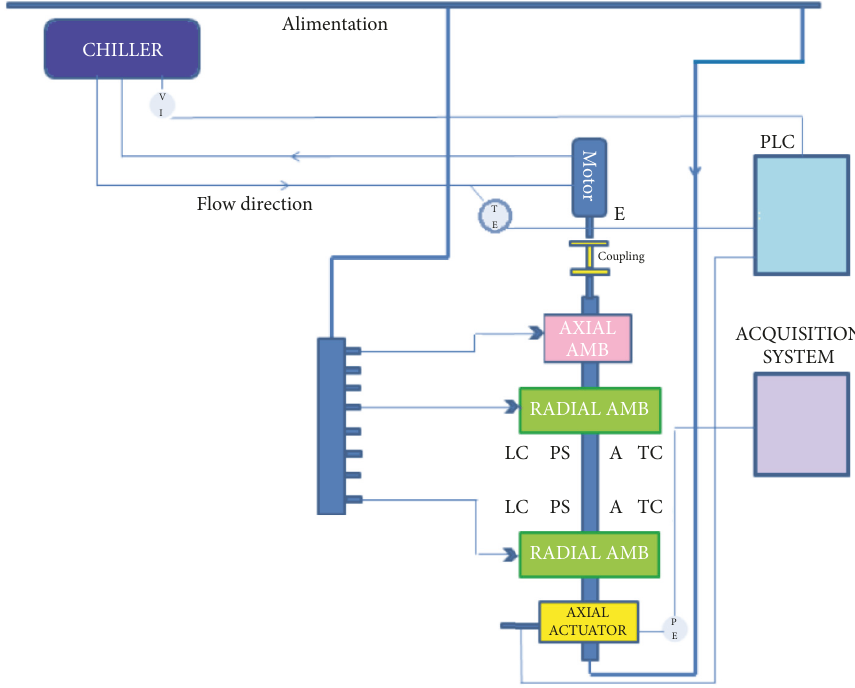
Figure 10: Scheme of the experimental